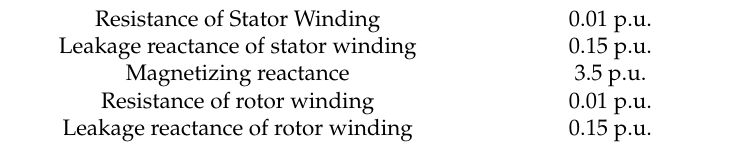
Figure 5. Overview of the adjustable speed generator (ASG) and its control system. Table 4. Electrical parameters of the doubly-fed induction generator (DFIG) as the